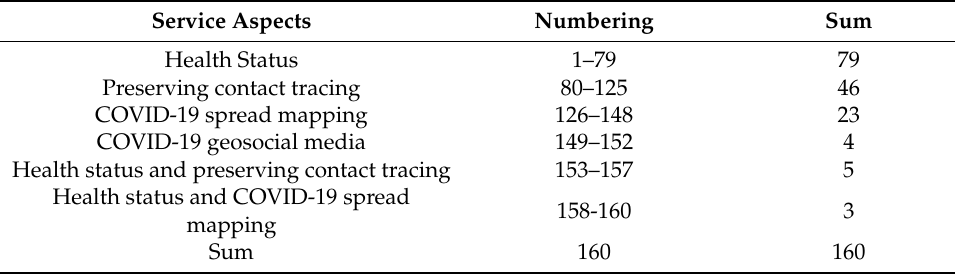
Table 1. COVID-19 LBMAs services’ categories.